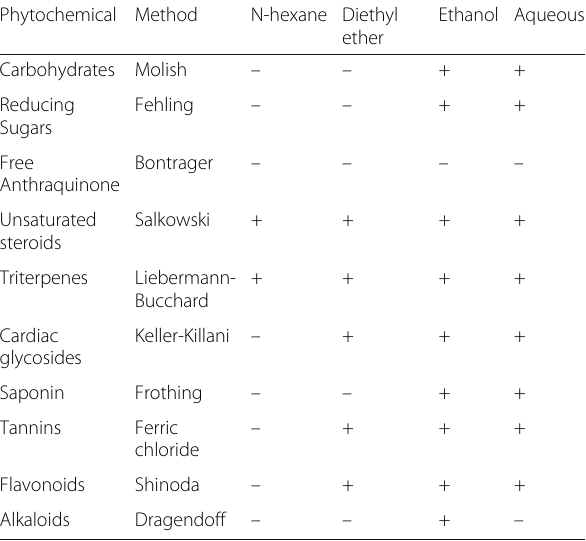
Table 2 The Qualitative Determination of Phytochemicals in n-Hexane, Diethyl Ether, Ethanol and Aqueous Extracts of Feretia apodanthera